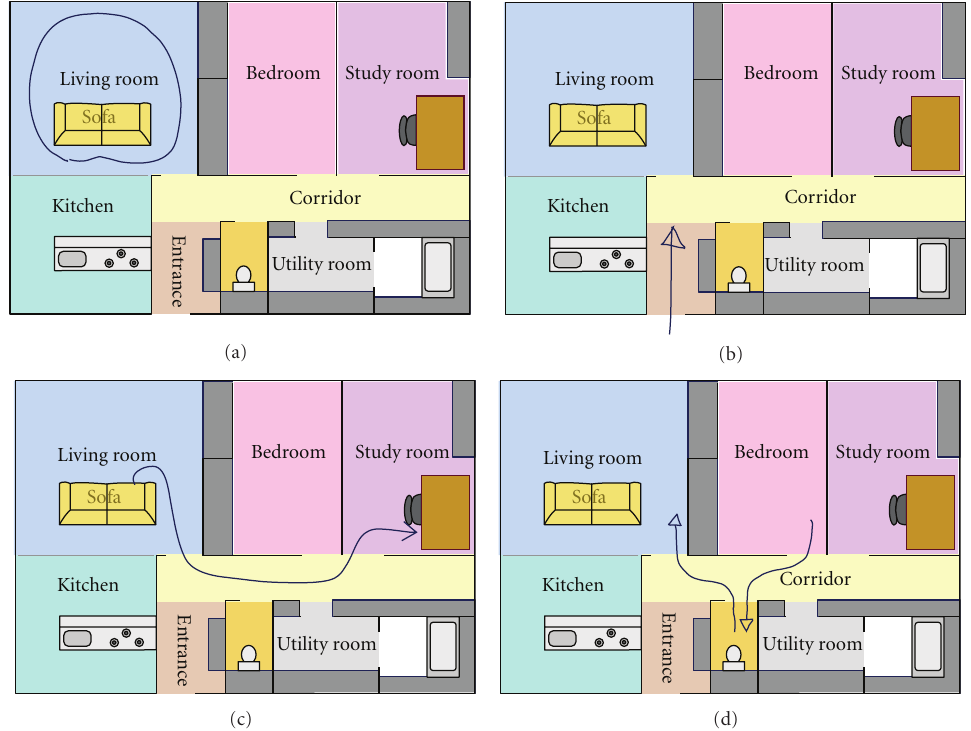
Figure 5: Some example sketches by test subjects for di ff erent movement patterns: (a) walking inside the living room, (b) entering the house, (c) walking from the sofa to the table in the study, and (d) walking from the bedroom into the toilet and entering the living room after a short